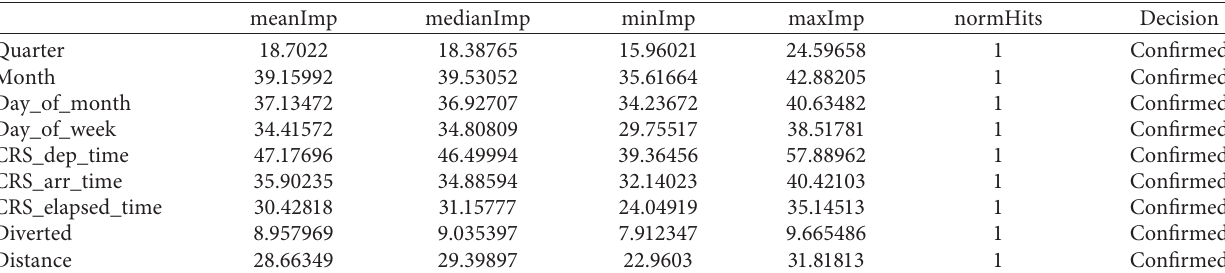
Figure 5: Features selection results: (a) departure; (b) Table 2: Departure dataset features importance.